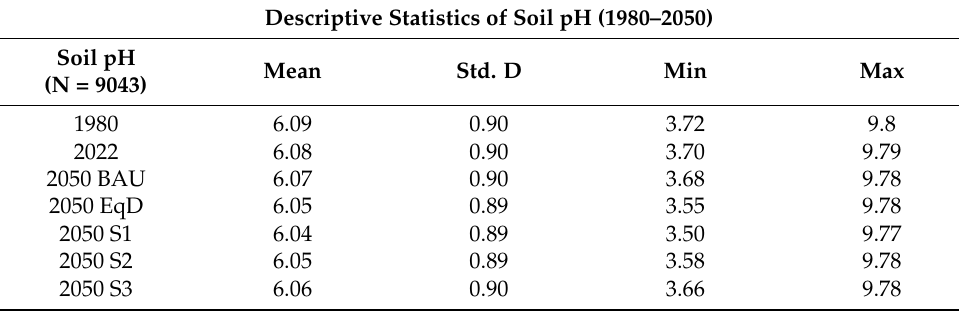
Table 2. Descriptive statistics of soil pH variation in different scenarios